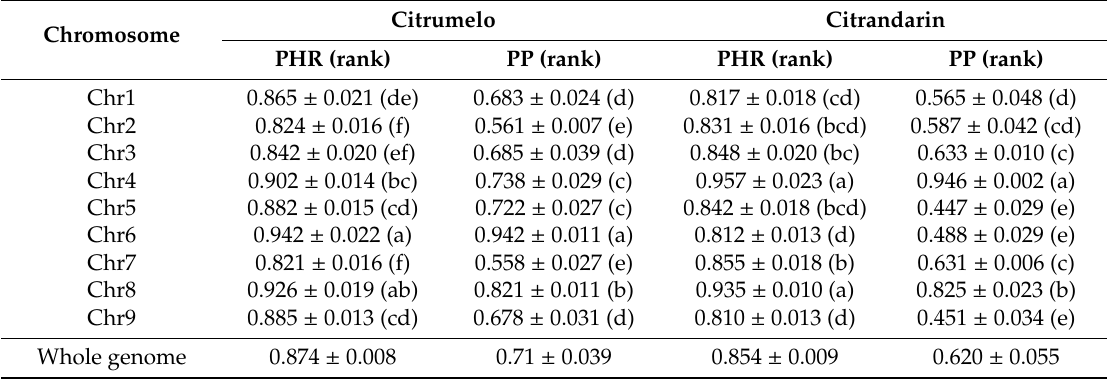
Table 3. Parameters of the meiotic behaviors of the tetraploid 4475 citrumelo and tetraploid citrandarin. Citrumelo Citrandarin Chromosome PHR